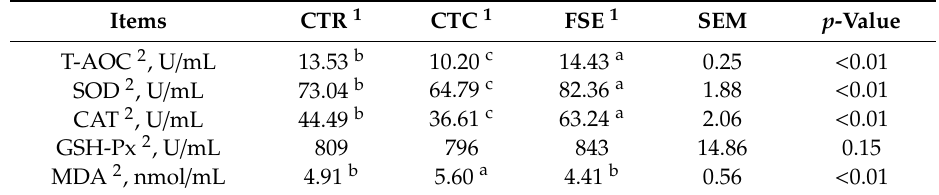
Table 7. E ff ects of Forsythia suspense extract on antioxidant status in serum of weaned piglets on day 28. Items